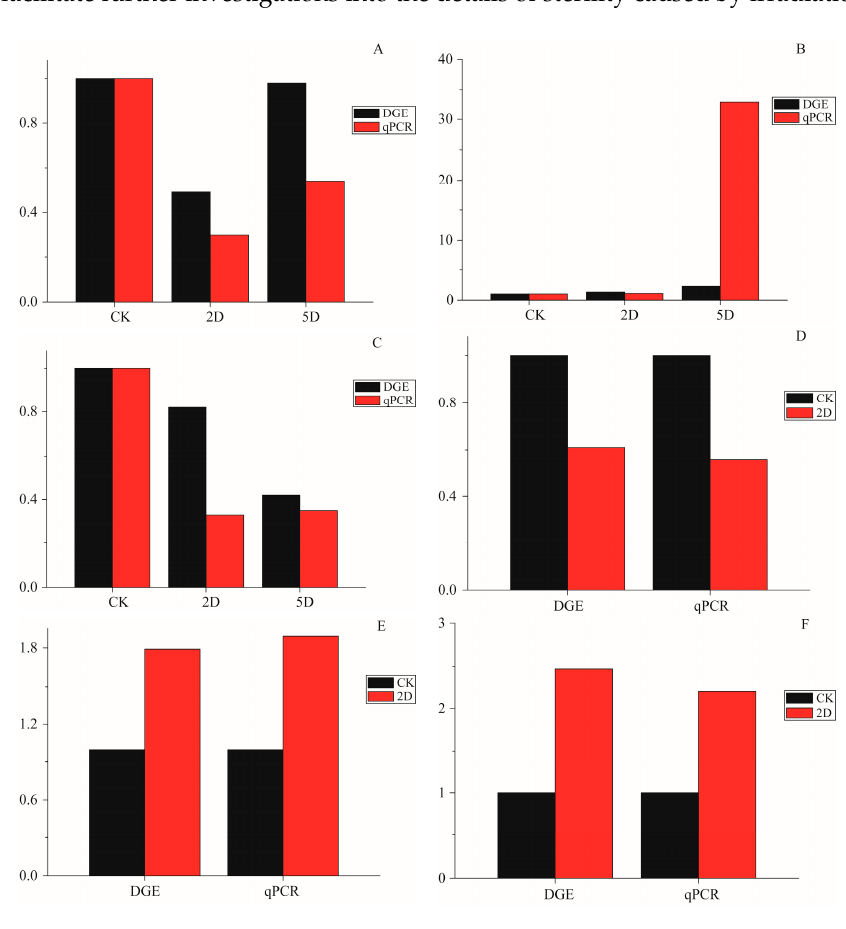
Figure 6. Cont . Figure 6.